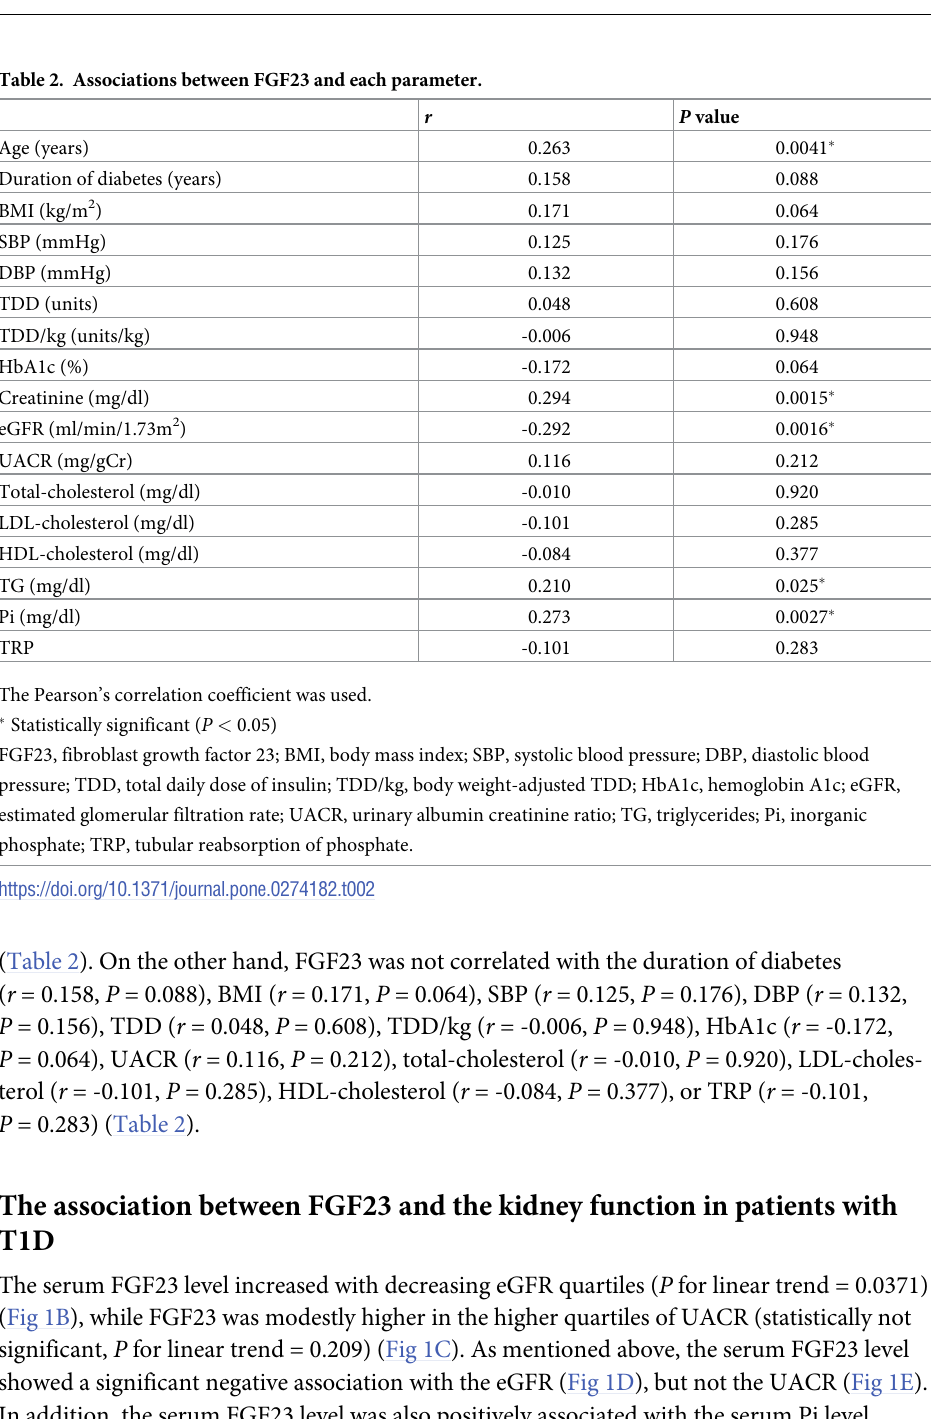
Table 2. Associations between FGF23 and each parameter.